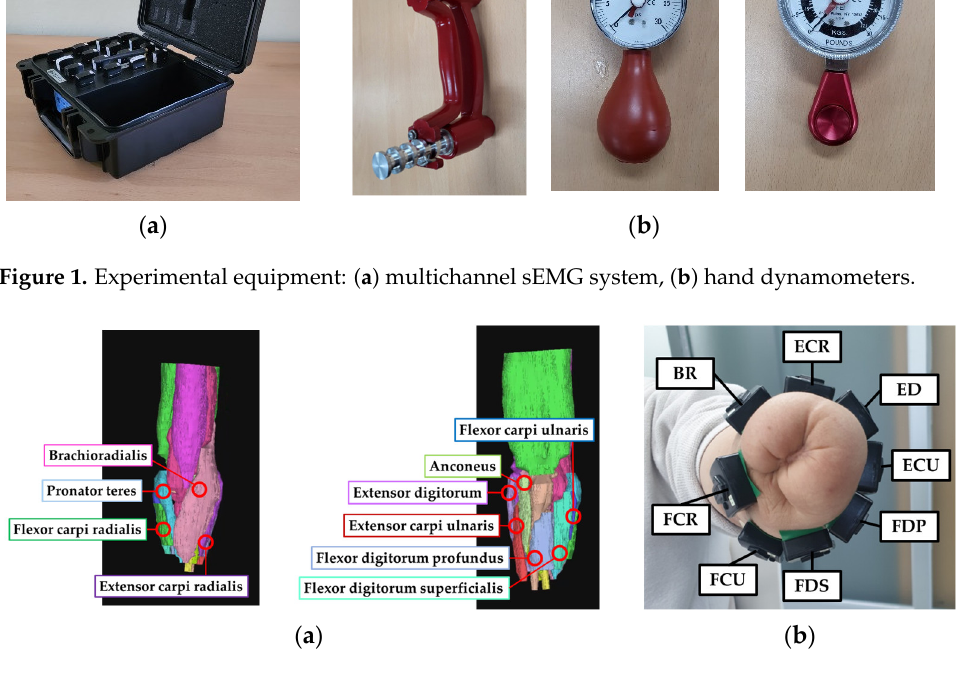
Figure 2. The amputated limb of the forearm amputee: ( a ) 3D reconstruction data of the forearm amputee, ( b ) position of the sEMG sensors on the forearm amputee.